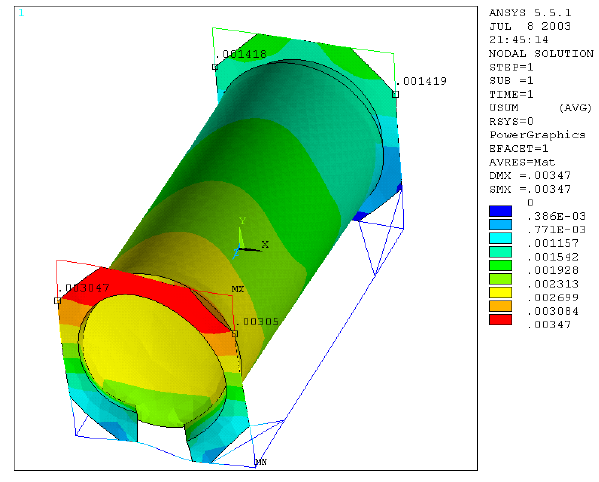
Figure 14. Nodal displacements.